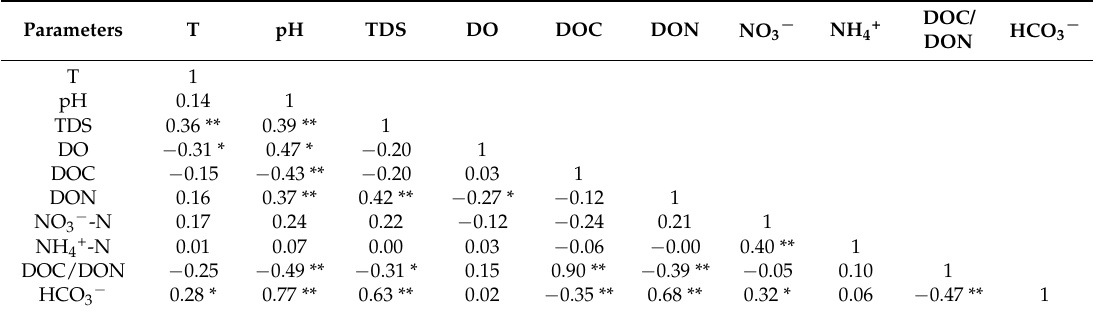
Table 1. Pearson correlation coefficients between C, N species and physicochemical parameters in the Mun River Basin,